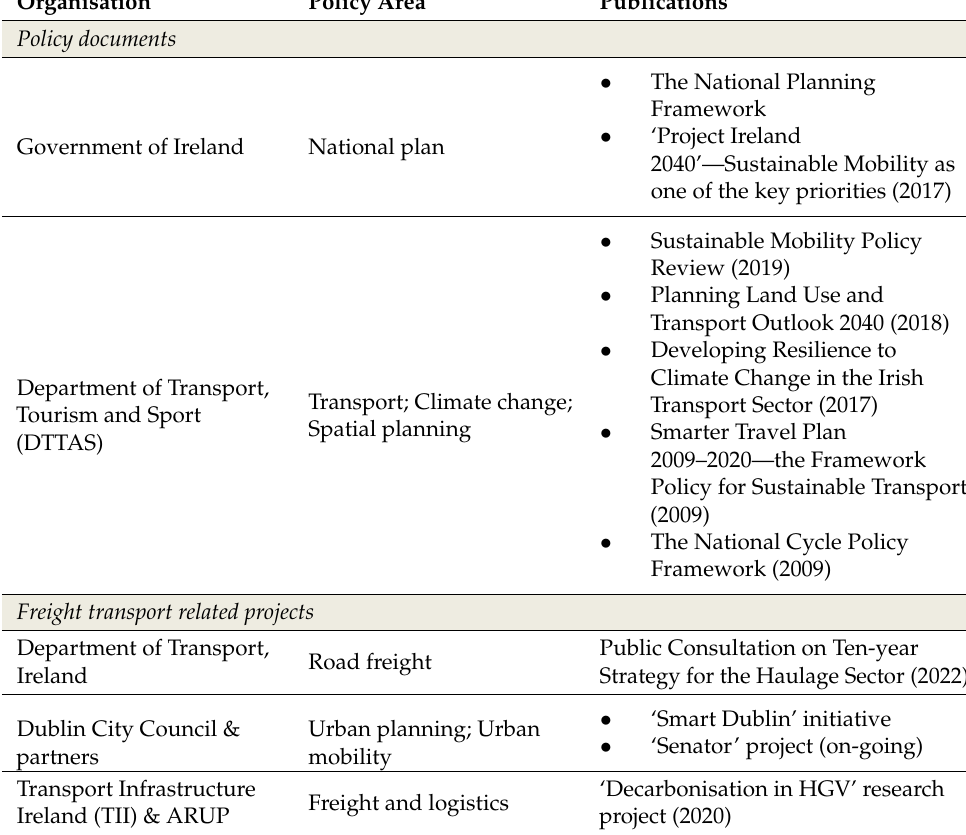
Table A1. Summary of sustainable freight transport-related policies and projects in